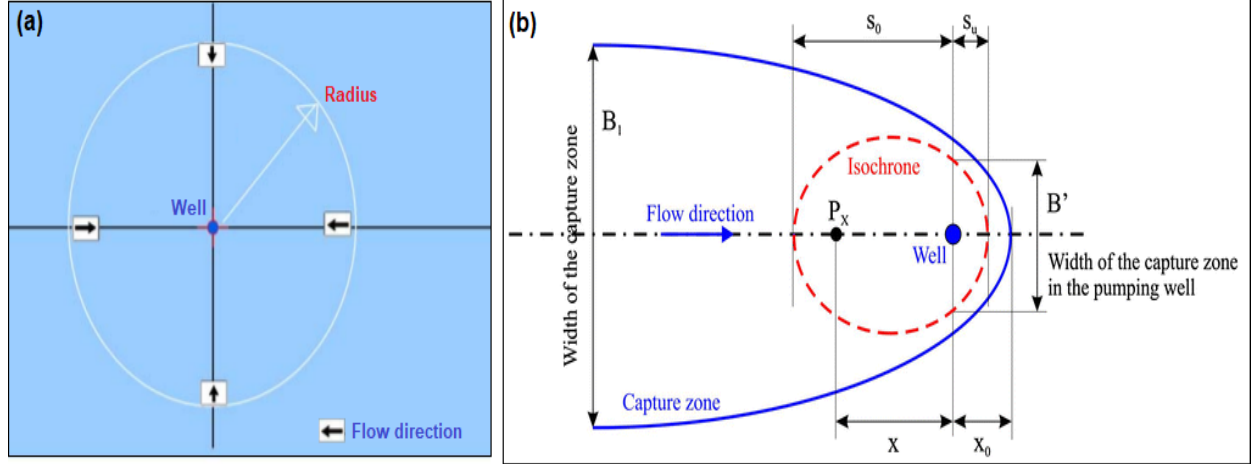
Figure 5. ( a ) The Fixed Radius methods and ( b ) WPA according to Wyssling’s method [2].